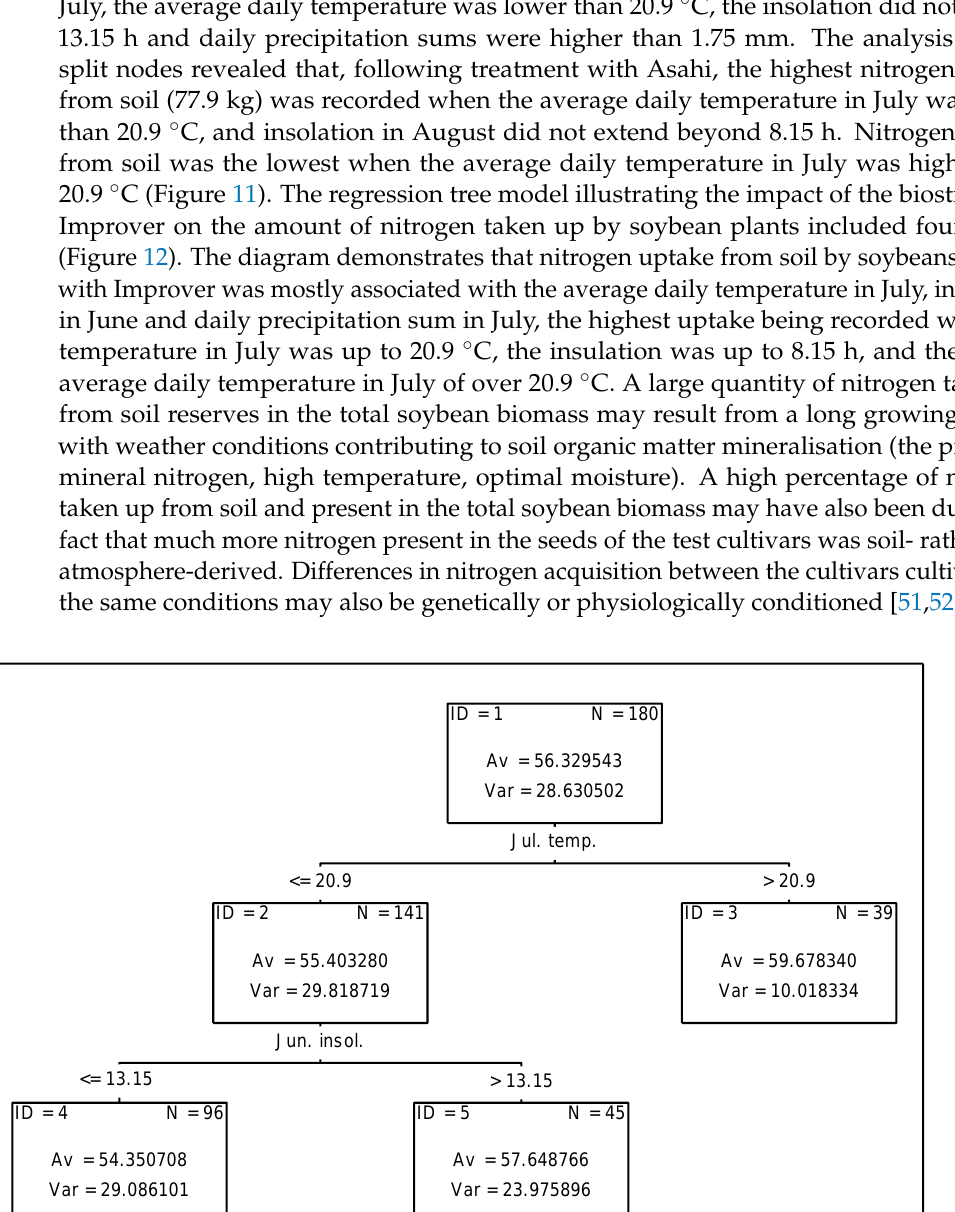
> 2.15 Figure 11. Diagram of regression tree reflecting nitrogen acquisition from soil by soy- bean plants treated with Asahi.